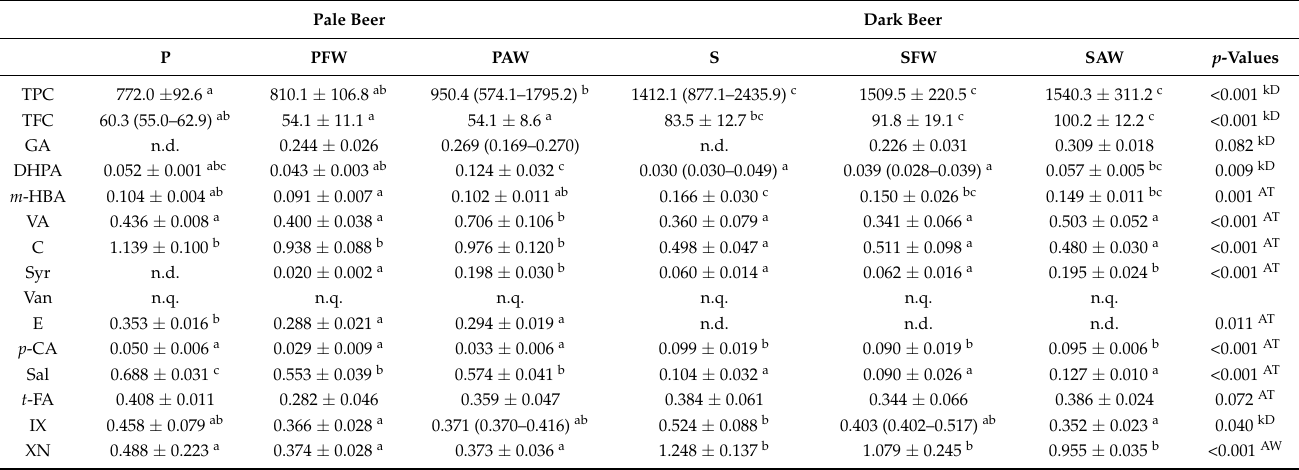
Table 2. Phenolics quantitative composition of the beer with and without maturation in American and French oak